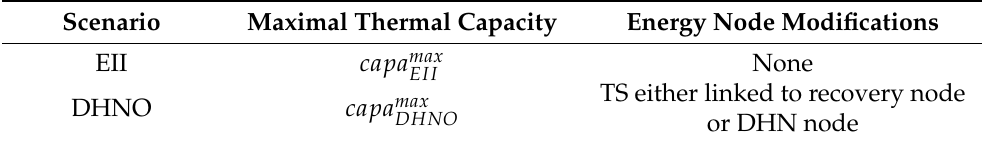
Table 5. Modifications of the energy model depending on the